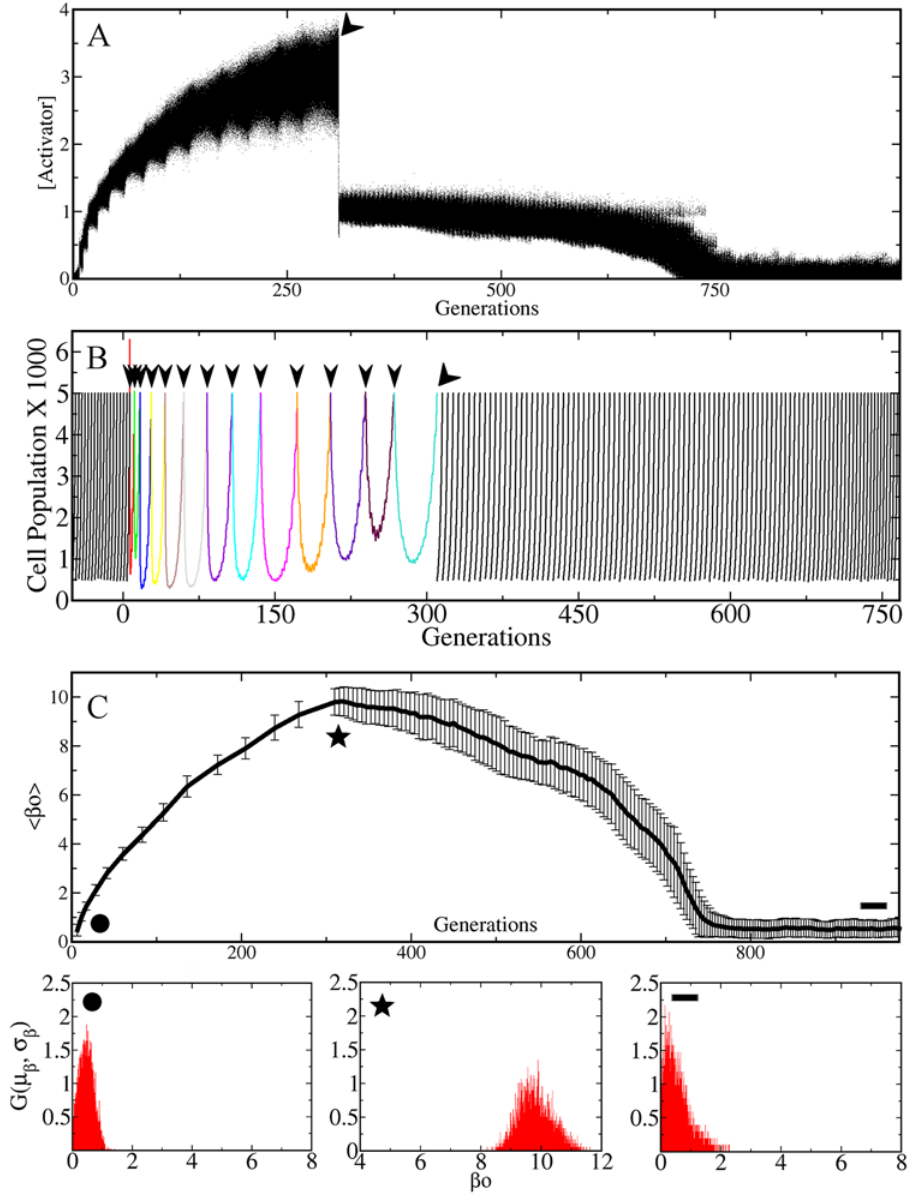
Fig 3. Reversibility of the resistance phenotype. (A) This tracking plot shows that the expression of the activator increases while the antibiotic shocks are applied as in Fig. 2. Then, when the antibiotic is removed (indicated by the tilted black arrow), the expression of the activator decreases abruptly and eventually reaches its basal level. (B) Size of the population as a function of time for the same simulation as in A. After each antibiotic shock (small black arrows) the population size decreases exponentially and the recovery time becomes longer with each shock. After the antibiotic is removed (tilted black arrow) the population comes back again to its wild-type (WT) growth rate. To carry out the simulations in the antibiotic-free phase, every time the population reached the maximum size N = 5000, we took a random sample of 10% of the cells and made them grow without antibiotic, until the population reached again this maximum size, and so on. (C) Average transcription rate μ β = h β 0 i in the population as a function of time. Note that the average increases while the shocks are applied and then gradually comes back to small values when the antibiotic is removed. Error bars indicate the standard deviation. It can be observed that the standard deviation increases with the antibiotic stress. The panels below show the full distribution G ( μ β , σ β ) at three different times: before any antibiotic is introduced (circle); after several antibiotic shocks (star); after a long period of time without antibiotic (line). Time is measured generations, being one generation the time it takes for a cell with β 0 = 1 to reach θ F starting from F =